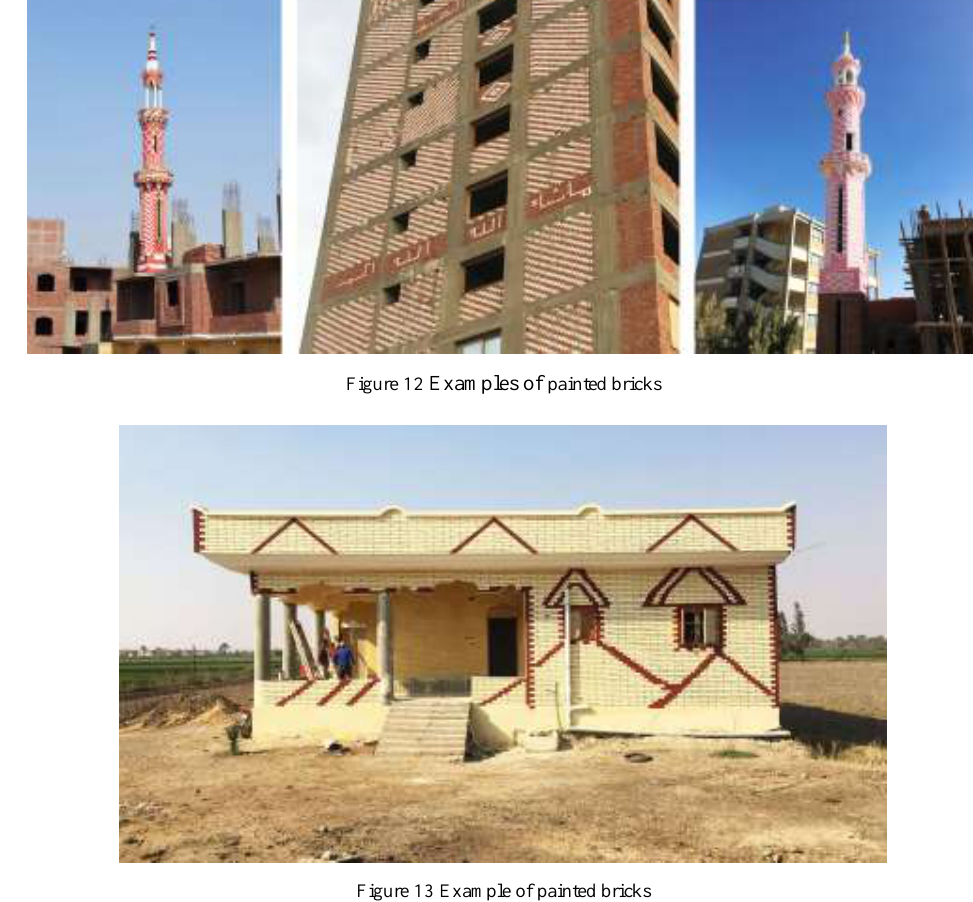
Figure 13 Example of painted